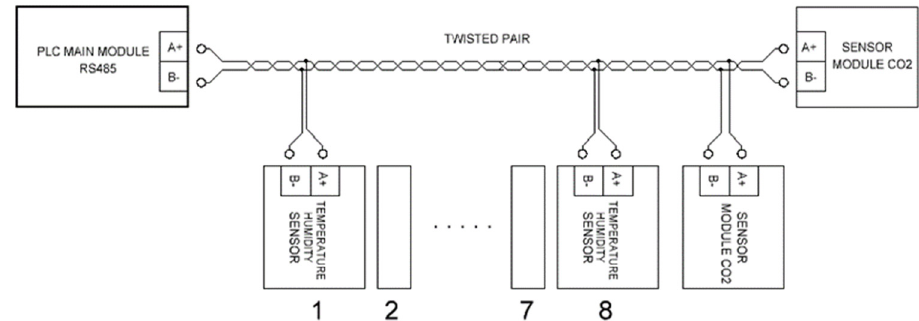
Figure 7. Network configuration diagram.